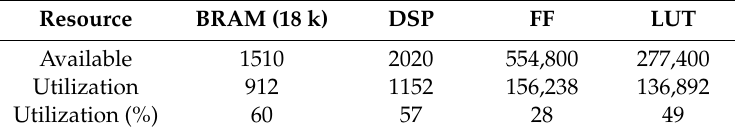
Table 2. Resource utilization of the deep learning